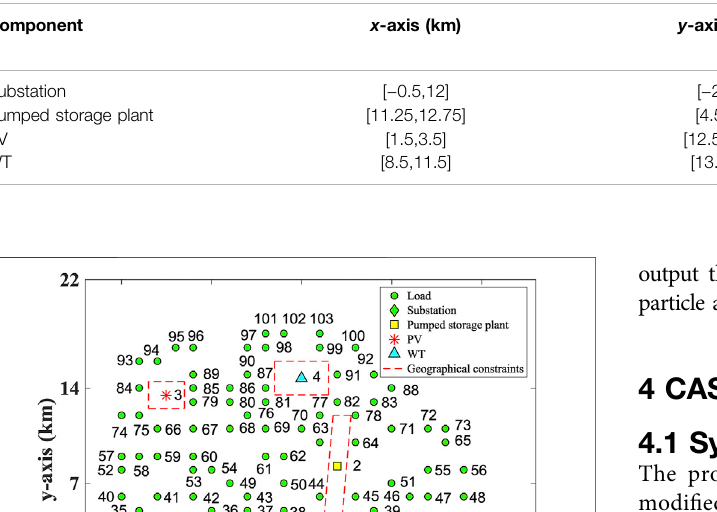
TABLE 1 | Geographical constraints of each component.